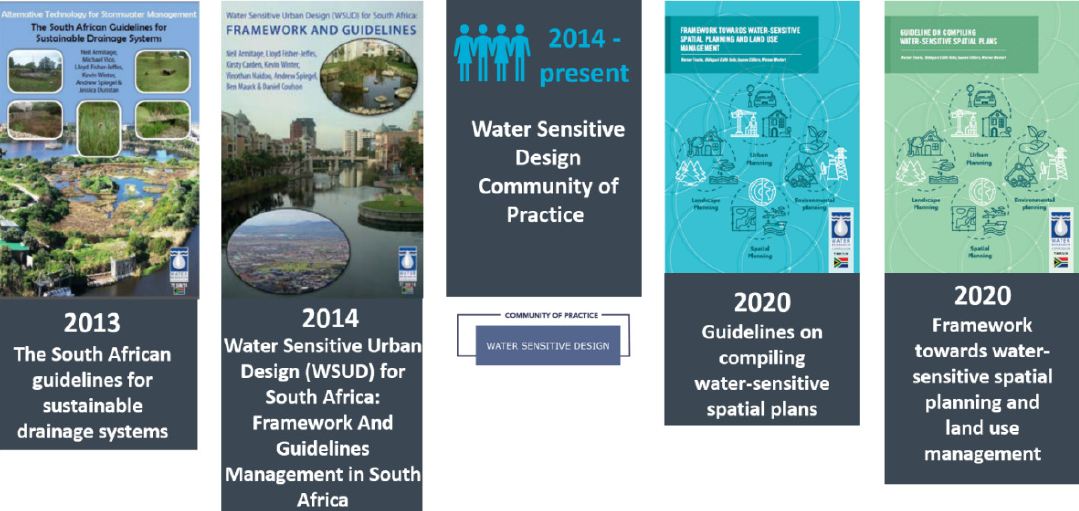
Figure 2. Milestones in the evolution of WSD in South Africa through the publication of guidelines and the establishment of the WSD CoP programme. Source: Authors, based on Armitage et al. (2013, 2014) and Fourie et al. (2020a,